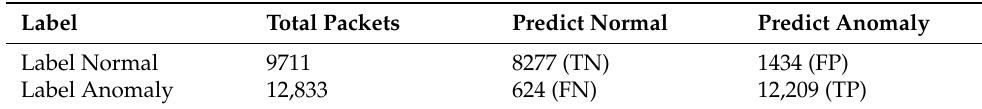
Table 10. Classification results of the ADA approach with the NSL-KDD dataset.